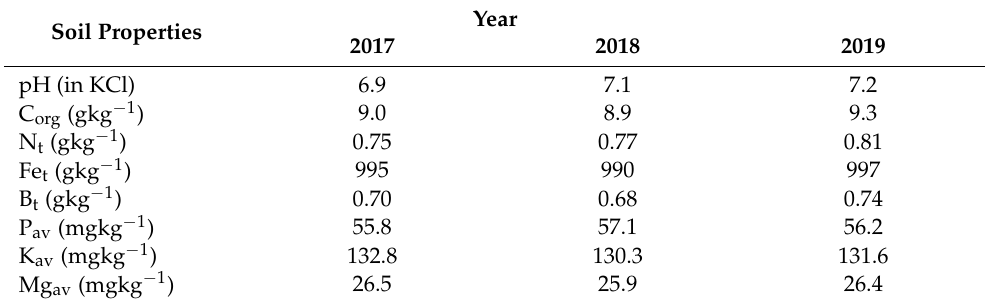
Table 1. Selected soil properties in the layer 0–0.25 m prior to the commencement of the experiment in 2017–2019. Soil